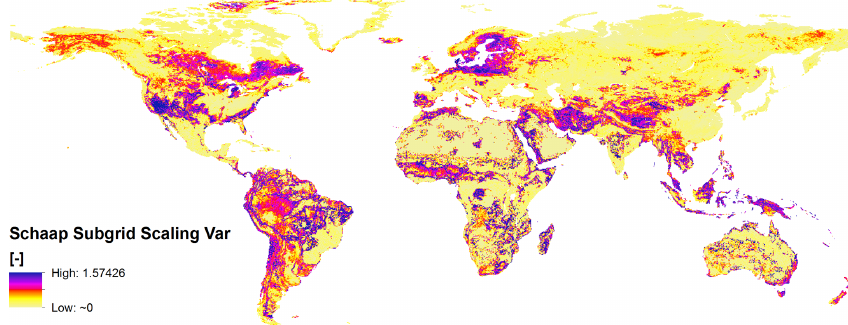
Figure 6. Global map of var(log 10 ˆ λ i ) calculated from SoilGrids1km data set and the Rosetta PTF (Schaap et al., 2001) for 0.25 ◦ resolution. Table 1. Variables stored in the final data set. The variable z indicates the soil depth, i.e. z ∈ [ 0 , 5 , 15 , 30 , 60 , 100 , 200 ] cm.